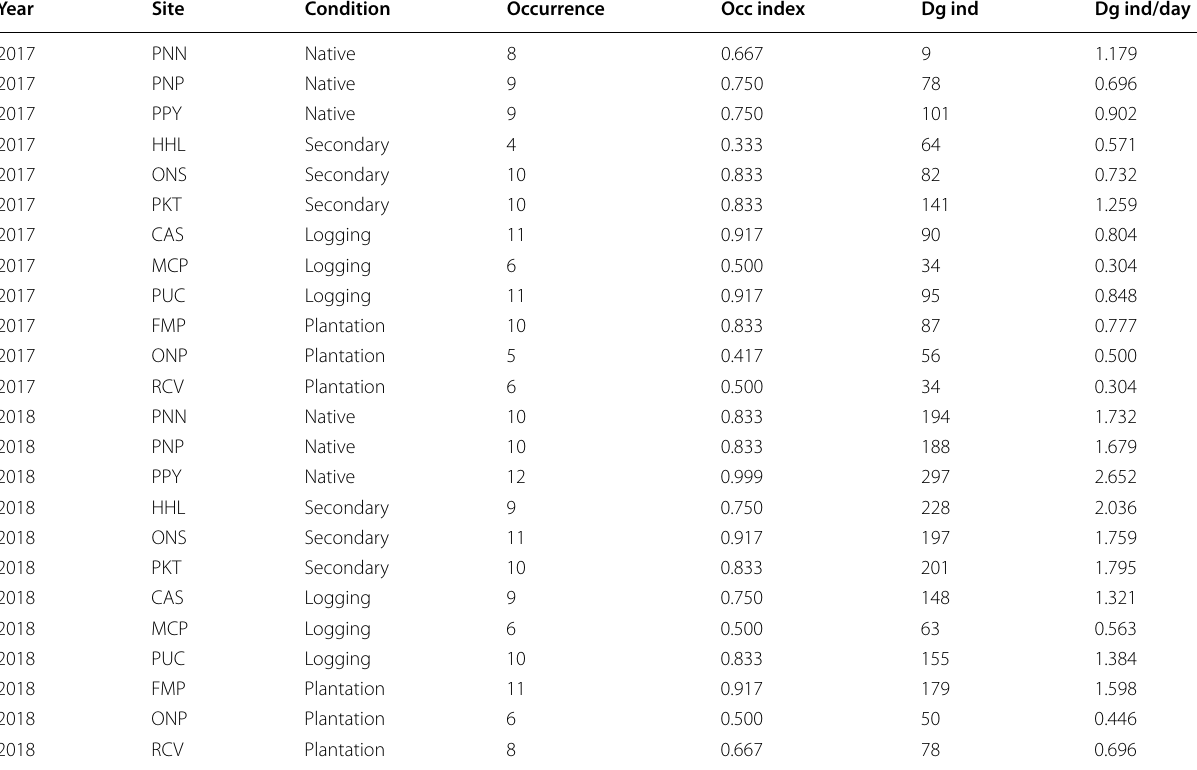
Table 1 Dromiciops gliroides occurrence and abundance data obtained from a two‑year (2017 and 2018) camera‑trap survey. Occurrence values represent the number of camera traps (of a total of 12) with at least one D. gliroides record; occurrence index represents the ratio between occurrence values and the number of camera traps installed. Dromiciops gliroides individuals (Dg ind) were estimated from camera traps after applying a 1‑h independence interval. Relative abundances are expressed as the number of D. gliroides individuals per